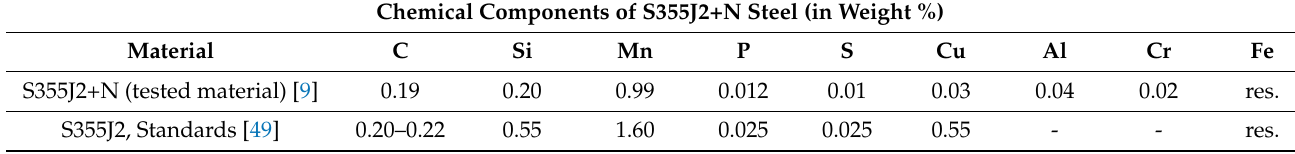
Table 1. Chemical composition of S355J2+N steel.